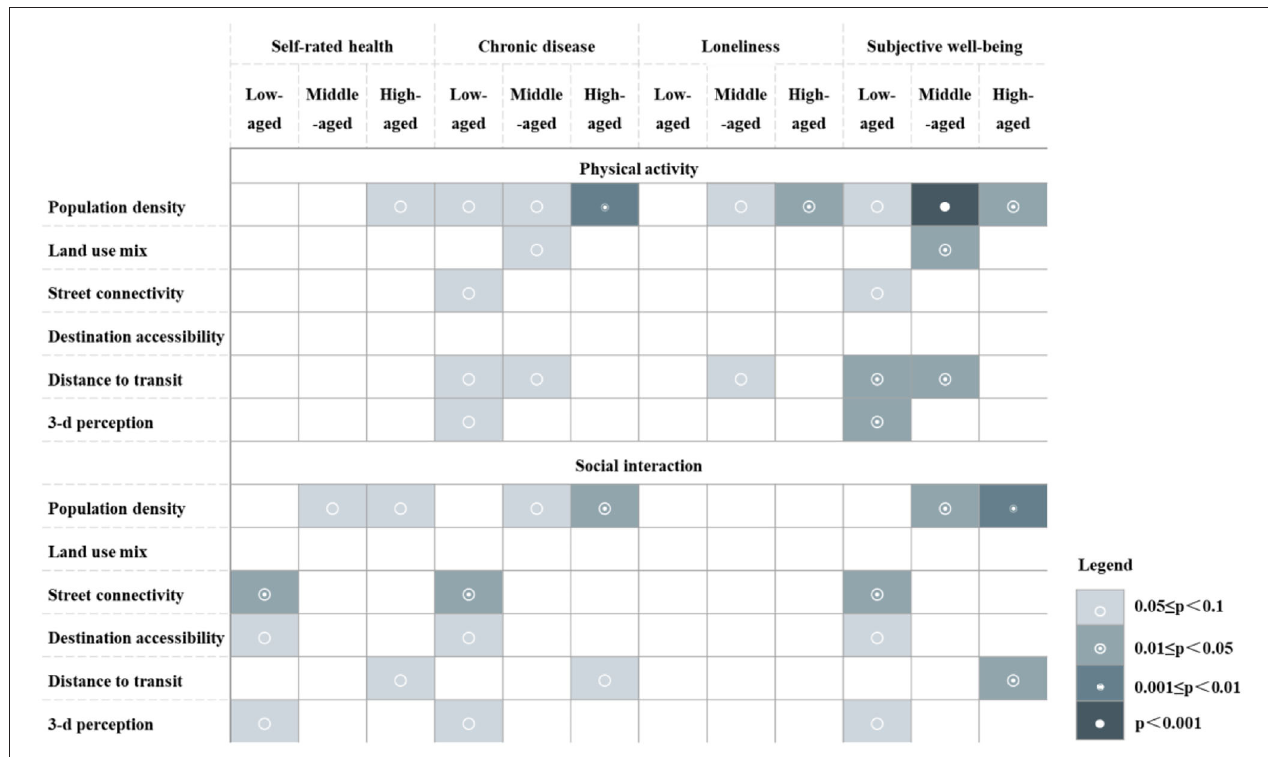
FIGURE 1 | Age heterogeneity of mediating effects of neighborhood-built environment on elderly